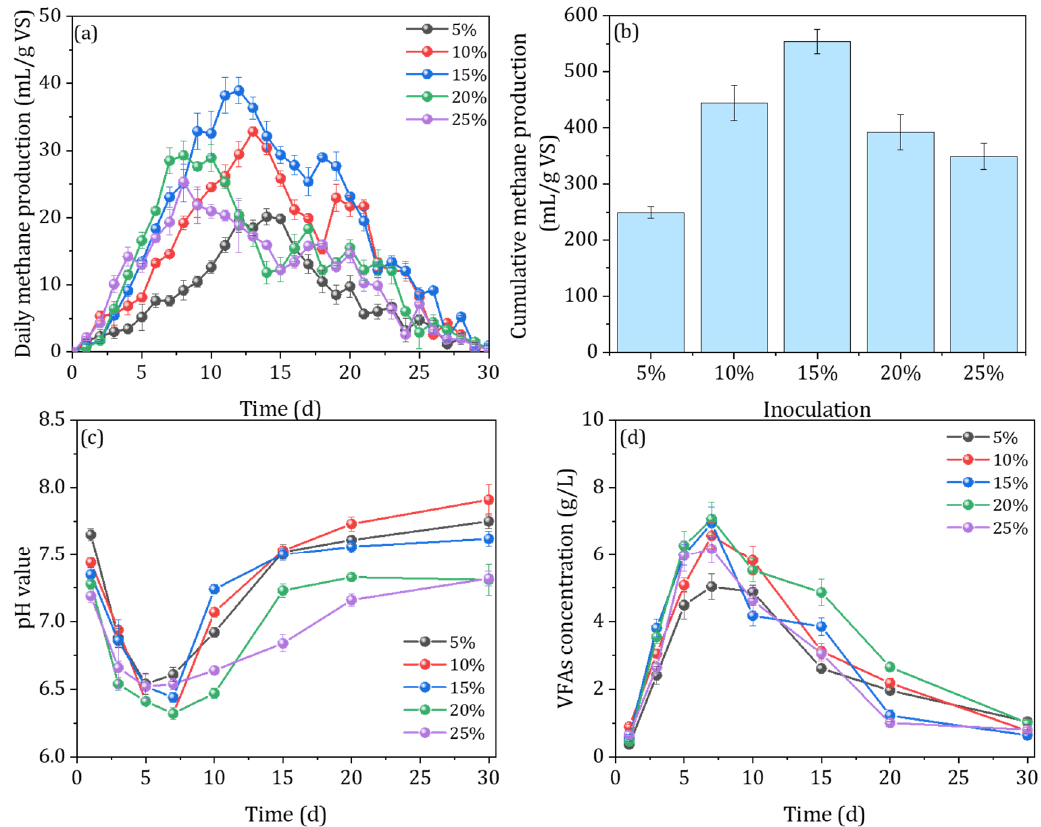
Figure 4. The daily methane production ( a ), cumulative methane production ( b ), the evolution of pH value ( c ), and VFA concentration ( d ) under different inoculation amounts, 1:5 mixing ratio, and 12% TS content.